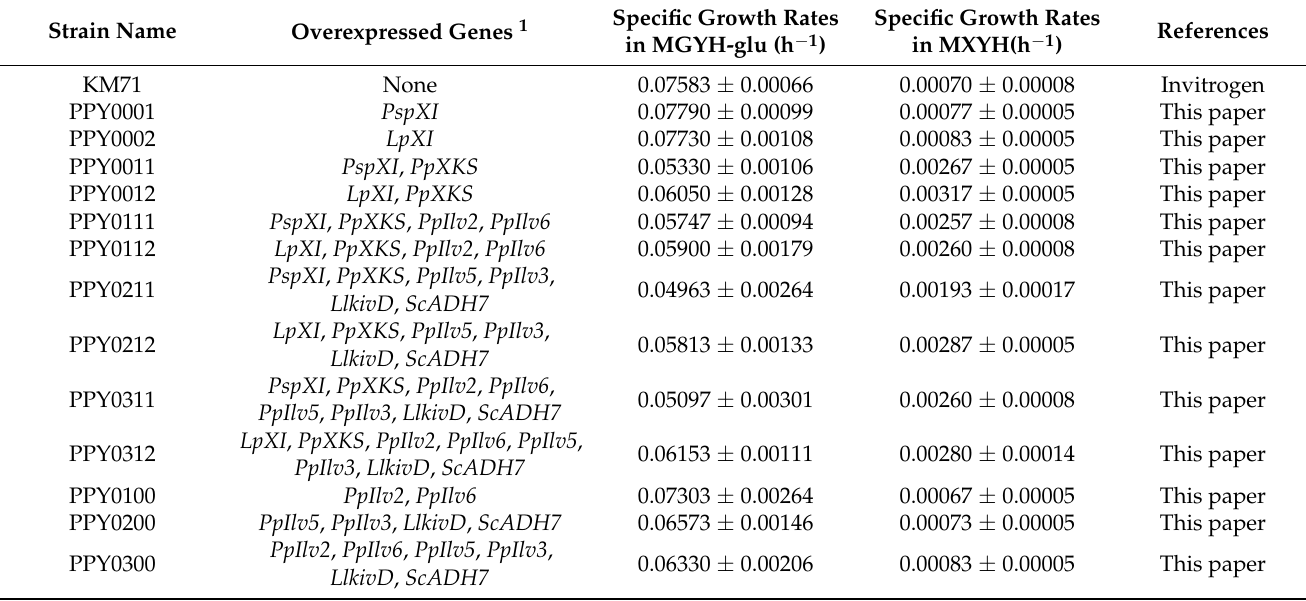
Table 1. Engineered strains generated in this